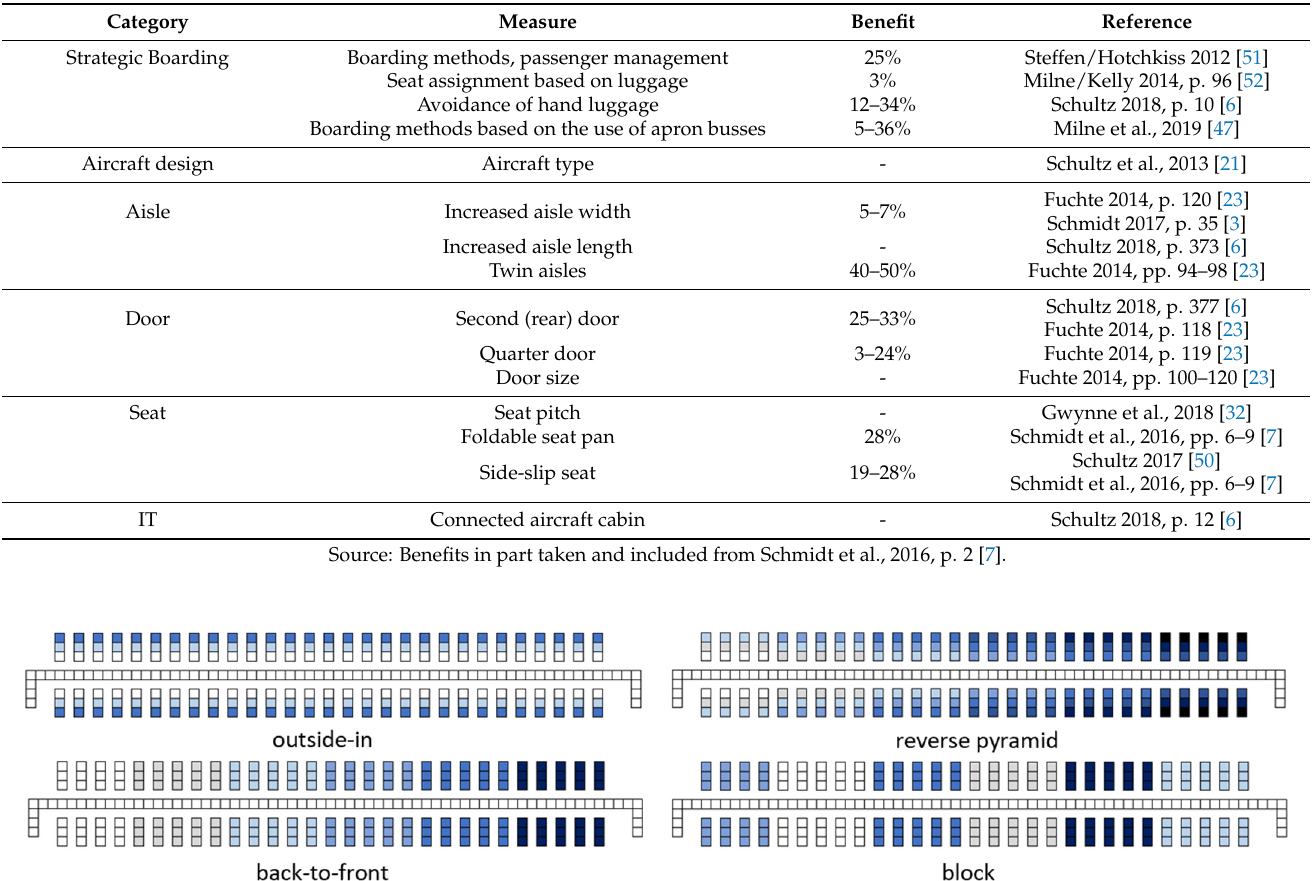
Table 1. Measures for improved boarding procedures.